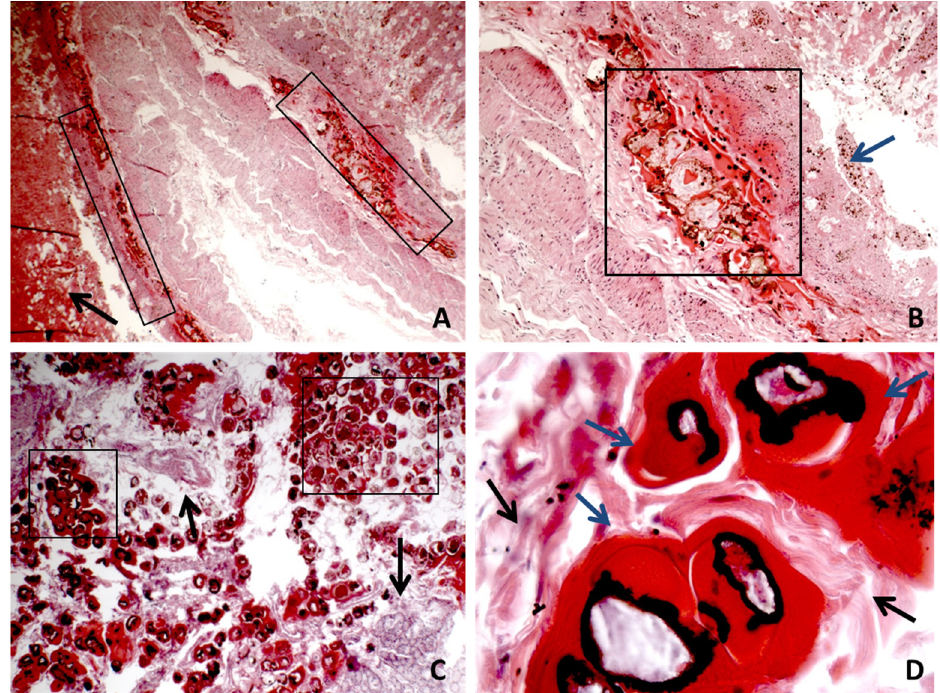
Figure 2. ( A , B ) The panoramic of wall interruption, with hemorrhage, necrosis, inflammation, and Enterobius vermicularis accumulation in different bowel sections. The black arrow indicates large areas of bleeding. The black box shows the presence of cross-sections of EV with interruption of the muscolaris mucosa. The blue arrow indicates the mucosa that is no longer recognizable cytologically due to destruction and necrosis (( A ) H&E ×4 magnification; ( B ) H&E ×10 magnification). ( C ) Area with a more evident presence of EV. The black box shows cross sections of EV; the black arrow indicates the residues of the intestinal wall fragmentation (H&E ×10 magnification). ( D ) High magnification of the transverse sections of the EV body; the black arrow indicates the residues of the intestinal wall fragmentation and the blue arrow indicate the EV body (H&E ×40).